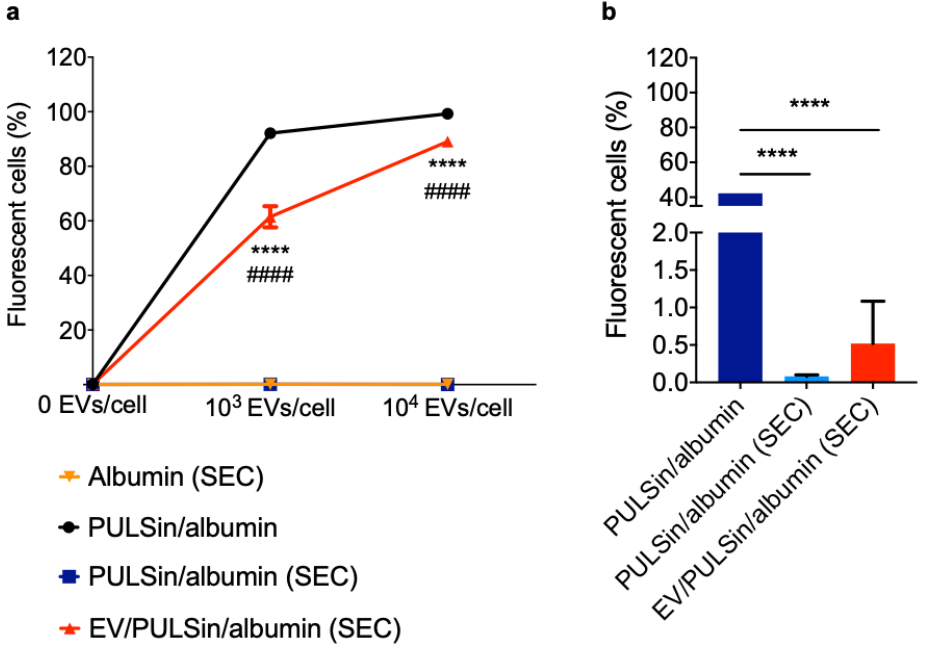
Figure 3. Uptake of albumin-loaded EVs in Raw 264.7 macrophages and MDA-MB-231 breast cancer cells. MDA-MB-231 human breast cancer cell-derived EVs were loaded with PULSin/albumin (albumin was labeled with Alexa Fluor 488). SEC was used to remove free albumin, PULSin and PULSin/albumin. The albumin amount in each sample loaded through SEC was equivalent and cells were treated with an equal volume of the elution fraction 7–9. Cellular uptake was assessed by flow cytometry after a three-hour incubation period. a Uptake of albumin-loaded EVs and controls in Raw 2647 cells. b Uptake of albumin-loaded EVs (10 3 EVs/cell) and controls in MDA-MB-231 cells. Data are presented as mean ± SD of three replicates. Statistical analysis was performed by two-way ( a ) or one-way ANOVA ( b ) with post-hoc pairwise comparisons using Tukey’s test. ****, p < 0.0001 in comparison to PULSin/albumin SEC; ####, p < 0.0001 in comparison to albumin (SEC) or PULSin/albumin (SEC).